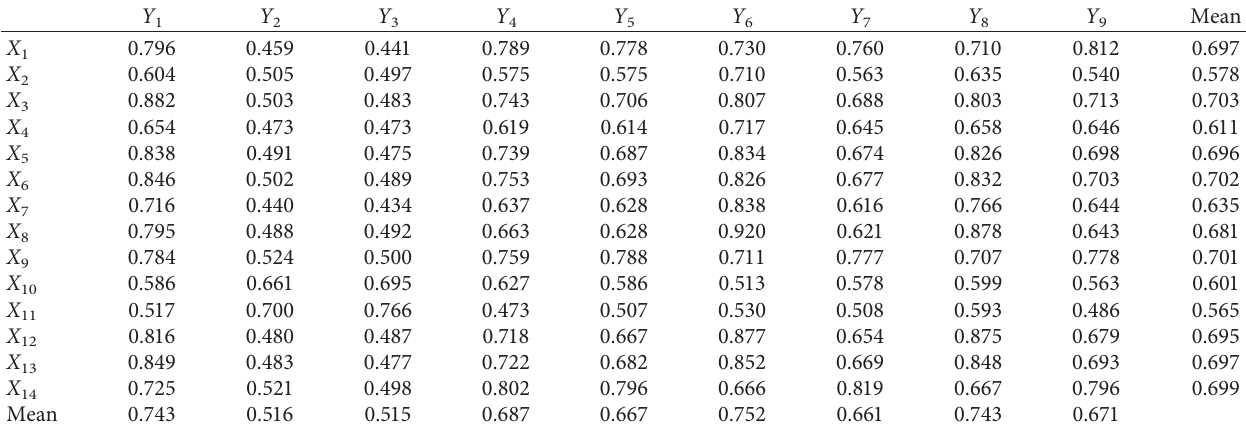
Table 8: Coupling effect matrix between the two